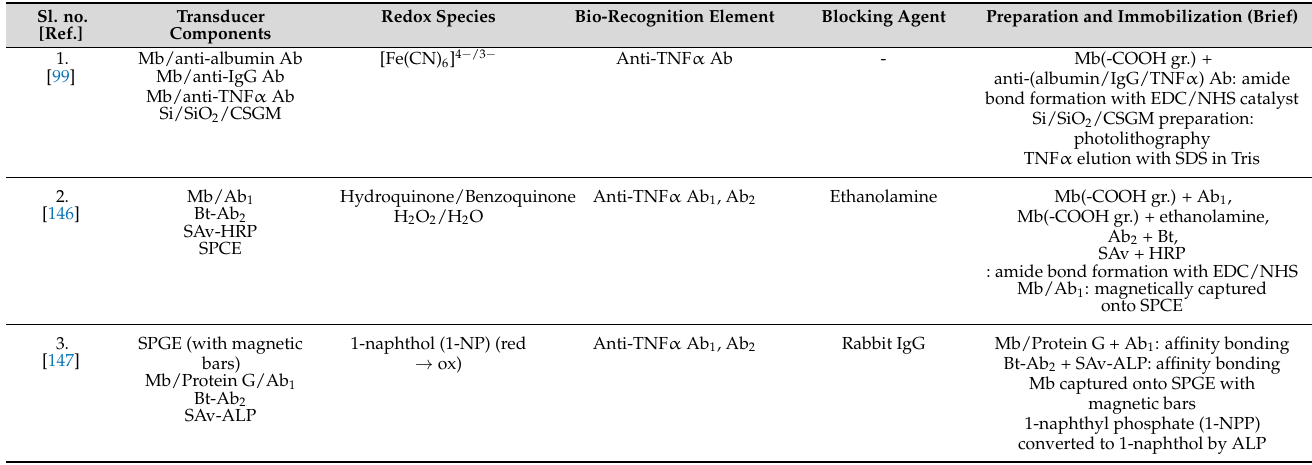
Table 11. Magnetoimmunosensors: Design and sensor preparation.